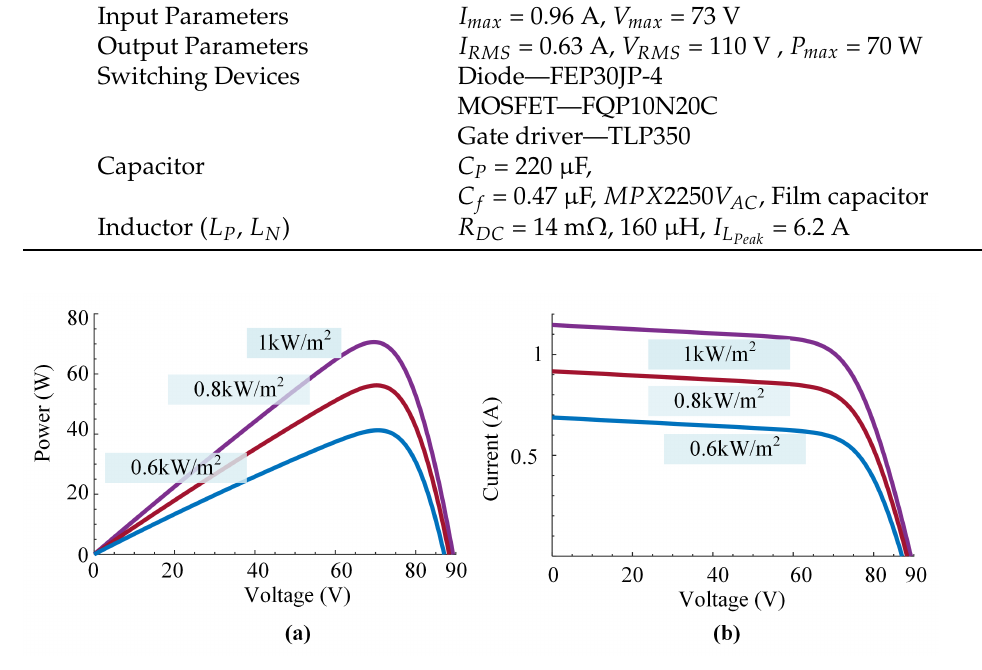
Figure 7. ( a ) PV voltage index versus Power. ( b ) PV voltage versus current for different irradia- tion level.